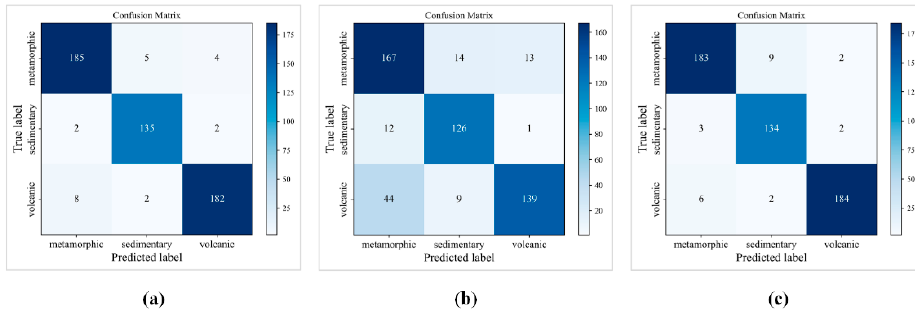
Figure 22. Confusion matrixes: ( a ) RMSprop optimizer; ( b ) SGD optimizer; ( c ) Adam optimizer.